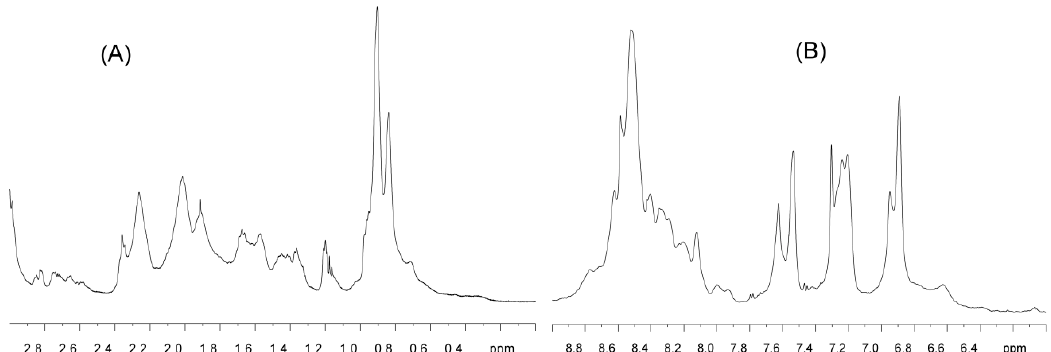
Figure 1. NMR characterization of C-LrtA: ( A ) Methyl and ( B ) amide regions of the 1D 1 H NMR spectrum of C-LrtA. Spectrum was acquired at 20 °C, and pH 7.2 (50 mM, Tris buffer).